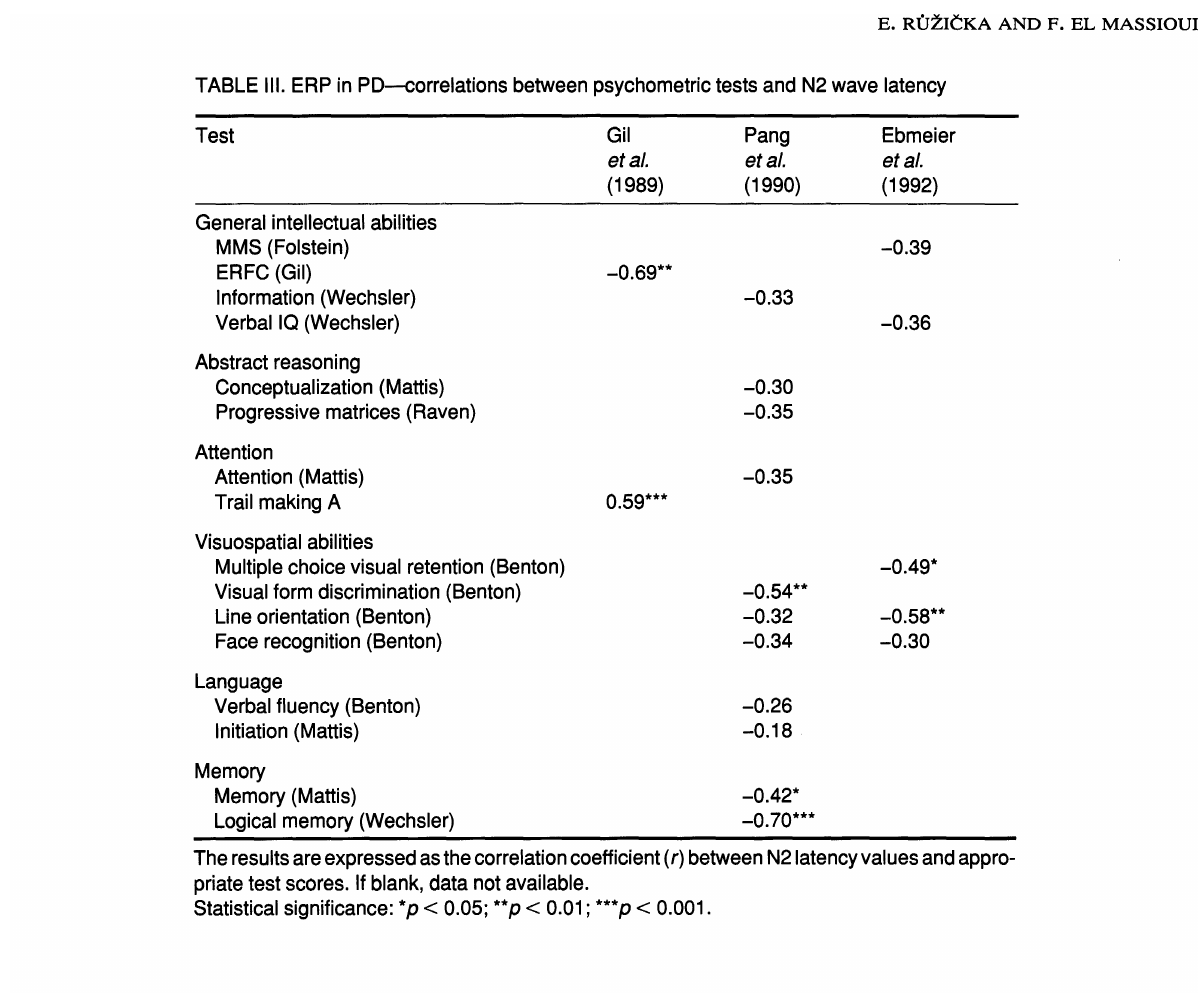
TABLE III. ERP in PD-correlations between psychometric tests and N2 wave